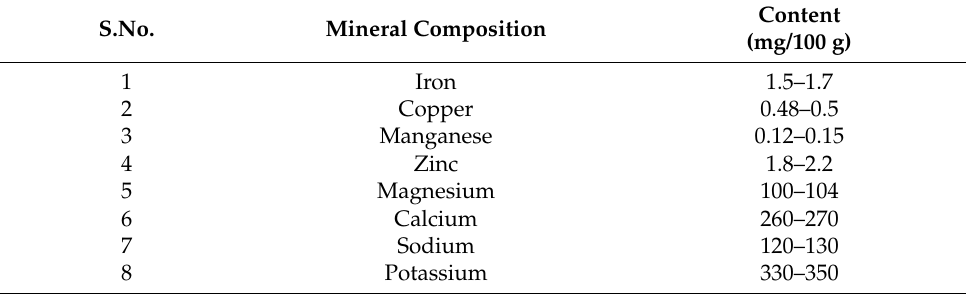
Table 2. Proximate mineral content of okra